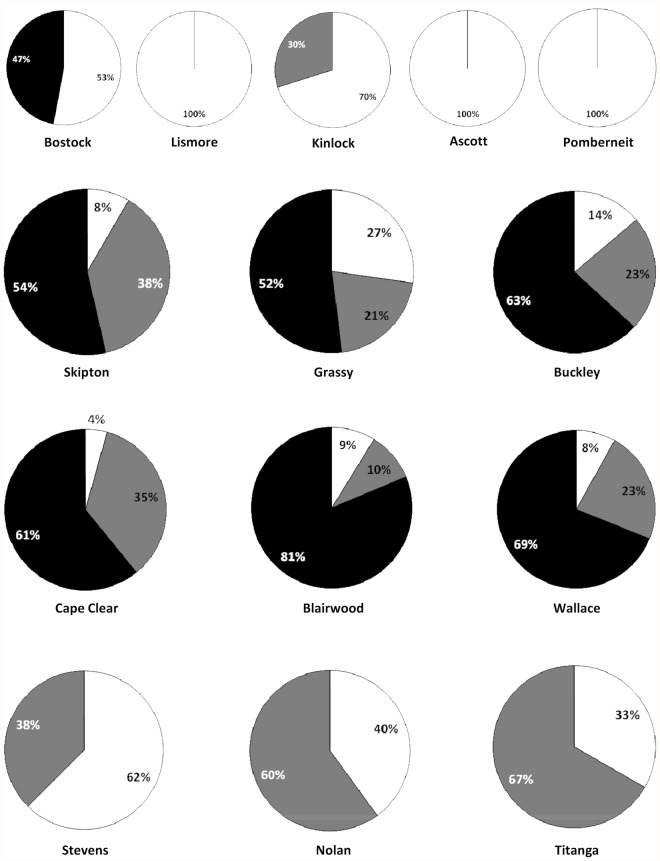
Proportion of Allocasuarina verticillata seed crops that could be ascribed to near-neighbour males (white), other sampled males (grey) and unsampled males (black).Pie charts ordered in rows top to bottom as small, linear, patch and restored populations.